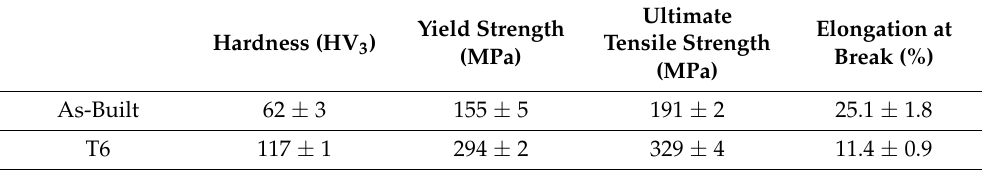
Table 4. Mechanical properties of the LPBF specimens in as-built and T6